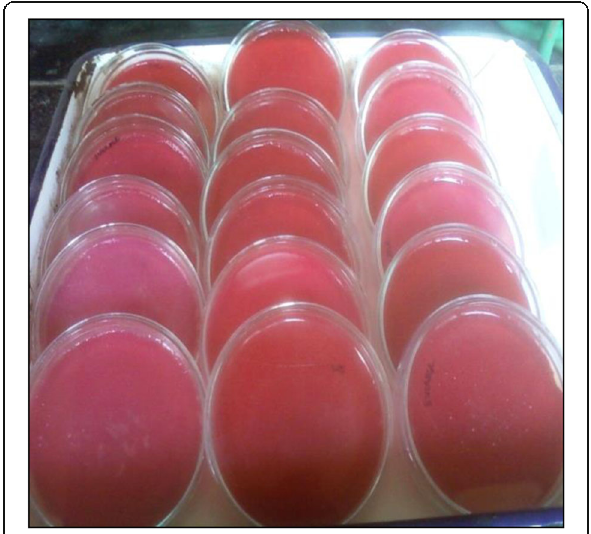
Fig. 9 Pigment production on Petri